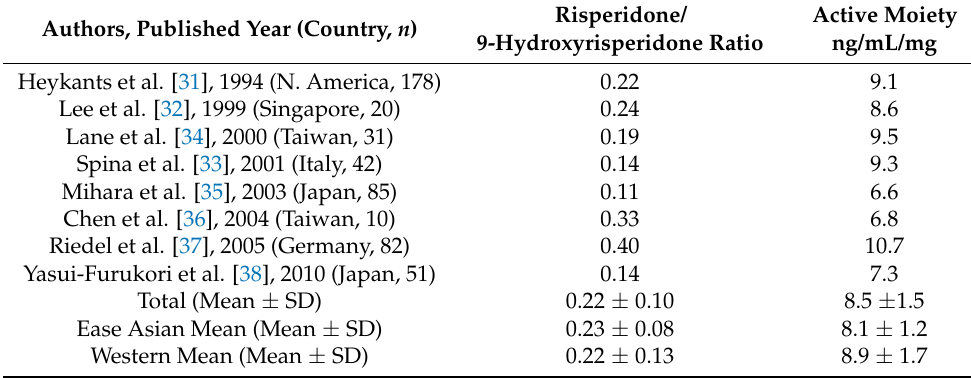
Table 1. Summary of selected 5 publications from East Asian and 3 from Western countries in the therapeutic drug monitoring of